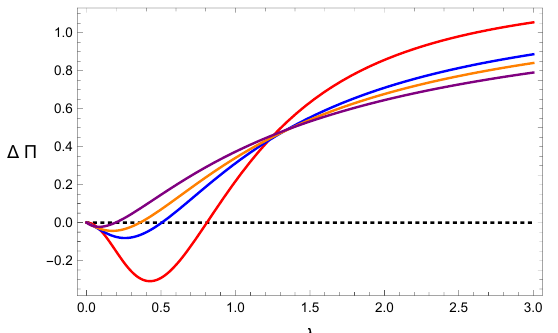
, (cid:25) , and (cid:25) . The minimum at 6 4 2 occurs at ( (cid:21); (cid:1)(cid:5)) = 2